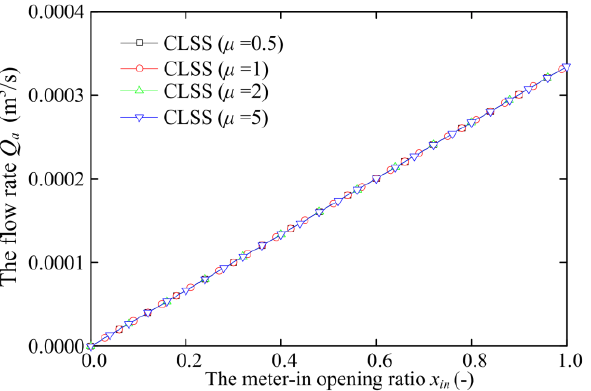
Figure 14. The rod chamber pressure P b of CLSS with extension working mode.